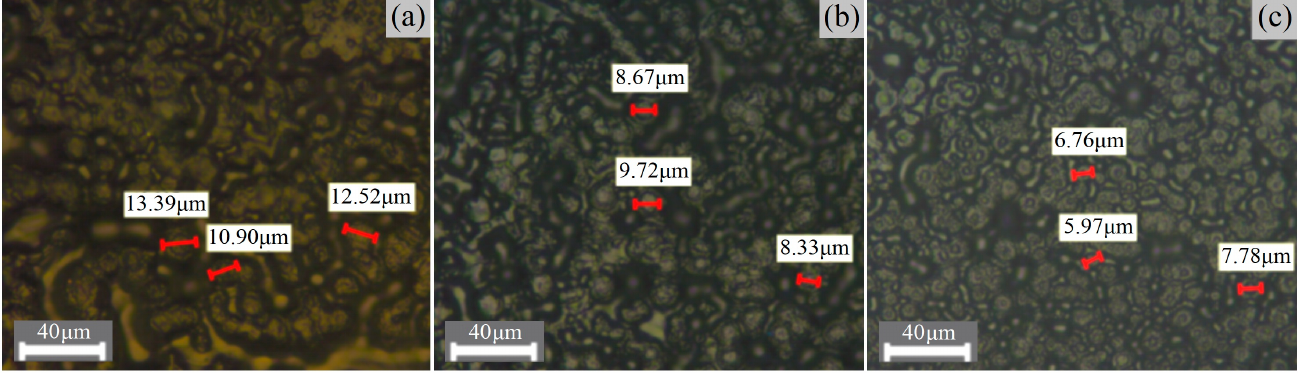
Figure 4. Spherulitic semi-crystalline morphologies of ( a ) XLPE, ( b ) XLPE-g-1.0wt%CAAE and ( c ) XLPE-g-1.0wt%MAH observed by PLM.